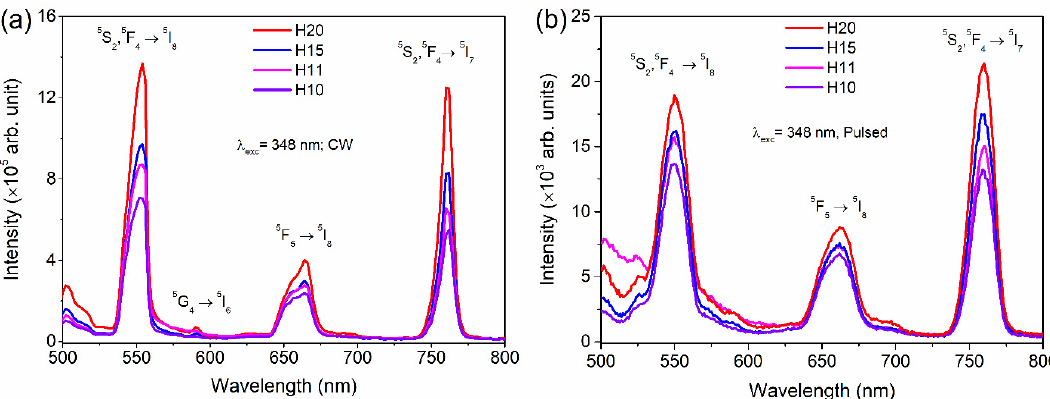
Figure 7. Downshifting spectra of Ho-SiAlON samples under 348 nm ( a ) CW excitation and ( b ) pulsed excitation.